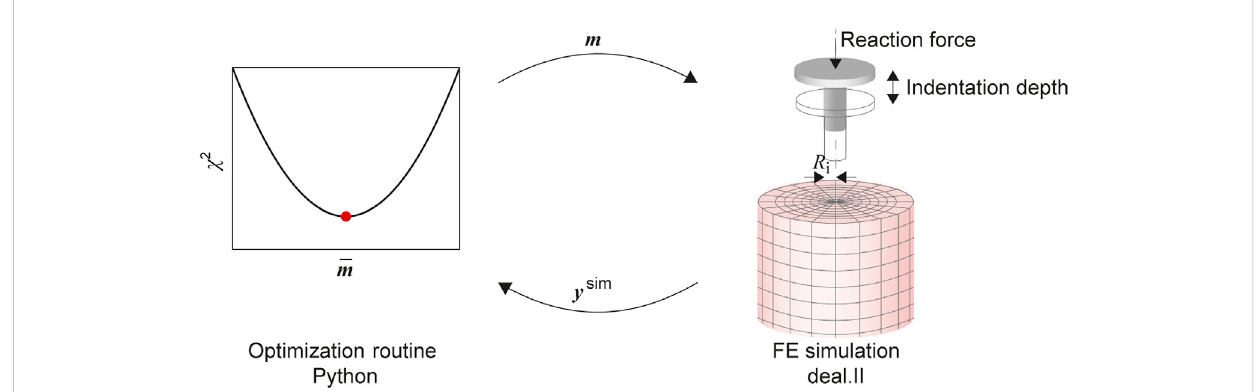
FIGURE 3 Theparameteridenti fi cationconsistsofanoptimizationroutine,implementedinthePythonmodule SciPy